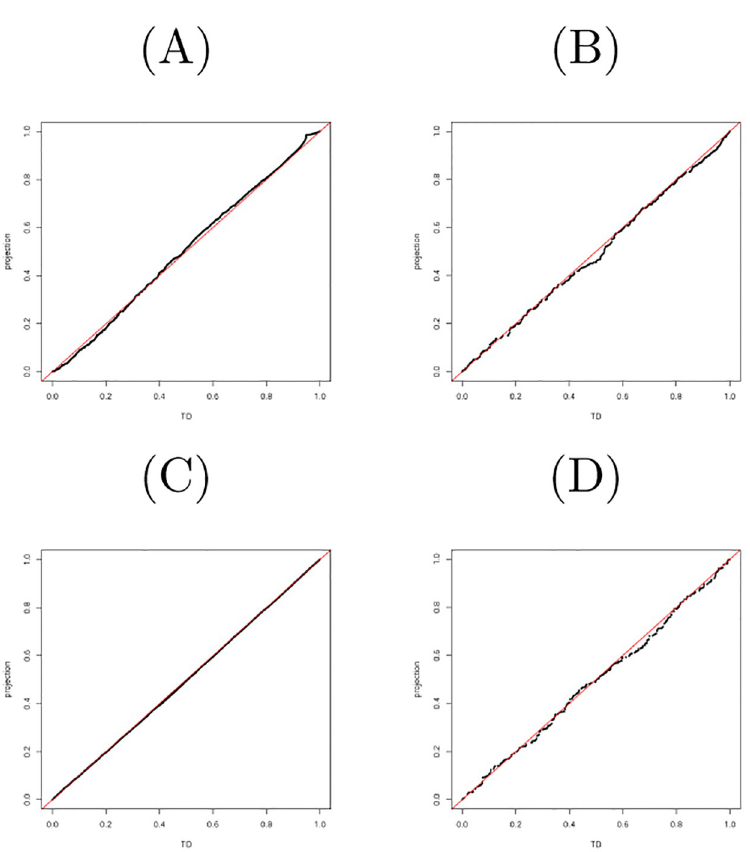
Fig 4. QQplot between P -values computed by TD-based unsupervised FE and projection (A) mRNA in the first data set (B) miRNA in the first data set (C) mRNA in the second data set (D) miRNA in the second data set.